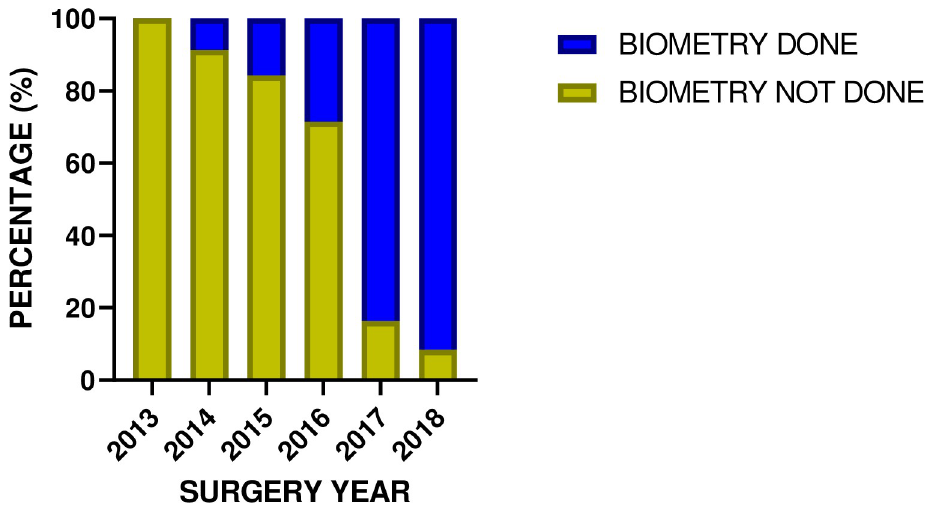
Fig 1. Distribution of biometry done over the years under study.